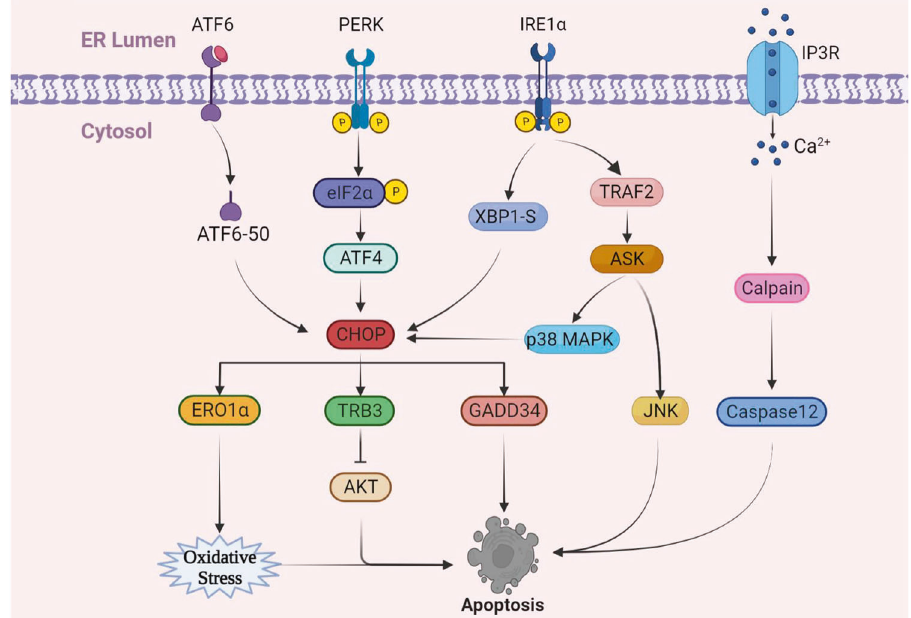
Fig. 3 The UPR induces activation of apoptosis. Apoptosis induced by ERS is similar to autophagy and is mediated by four major pathways, PERK, IRE1 α , ATF6, and Ca 2 + . Among them, the CHOP pathway is the main factor of apoptosis, and all three transmembrane sensors can induce apoptosis. ERS can also induce apoptosis through the IRE1 α -TRAF2-JNK pathway. In addition, apoptosis triggered by the Ca 2 + pathway is induced by the activation of its speci fi c factor,